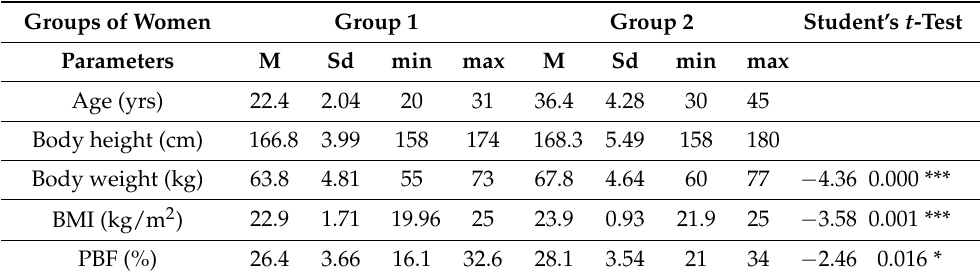
Table 1. Anthropometric characteristics of the studied groups. Groups of Women